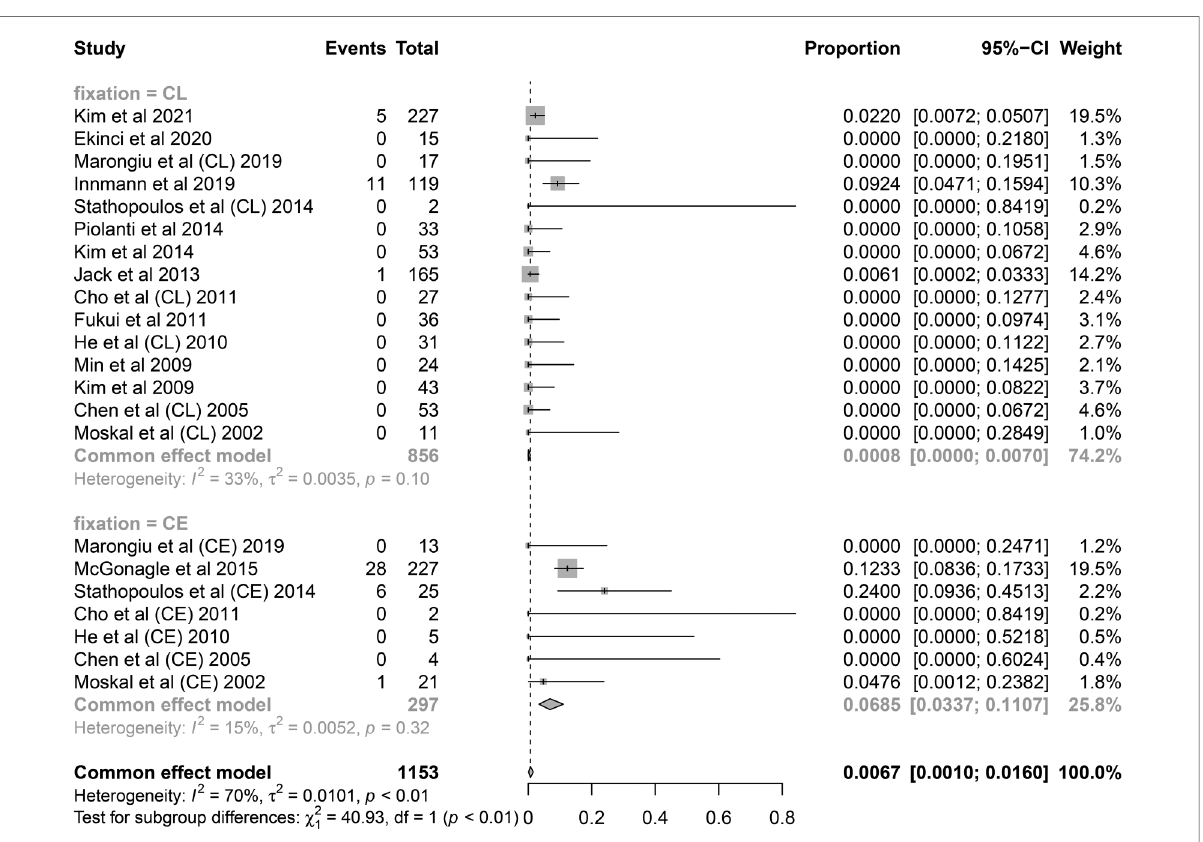
FIGURE 6 Subgroup analysis of re-revision rate by fi xation type. CL, cementless; CE,